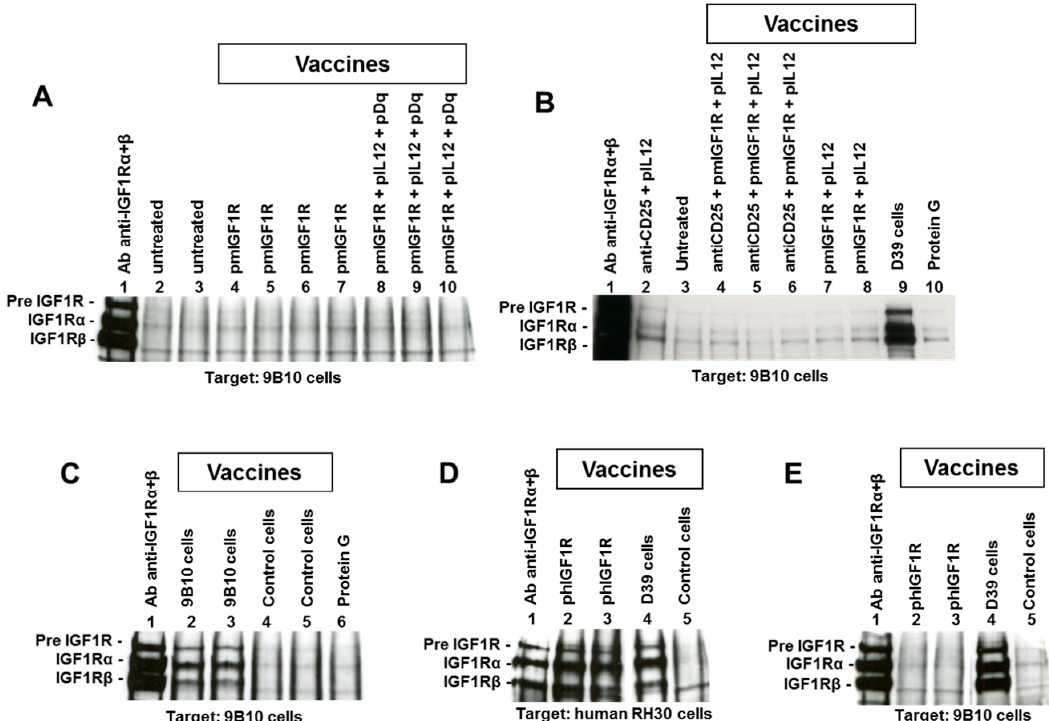
Figure 1. Immunoprecipitation and Western blot analysis of sera to evaluate the induction of antibodies recognizing murine or human Insulin-like Growth Factor Receptor-1 (IGF1R). In each panel sera used for immunoprecipitation are reported over each lane, while tumor cell lysate (target) is reported under each panel. For details, see the Materials and Methods section. ( A ) lane 1, positive control; lanes 2 to 3, sera from untreated BALB/c mice; lanes 4 to 7, sera from BALB/c mice after four vaccinations with pmIGF1Ropt plasmid; lanes 8 to 10, sera from BALB/c mice after four vaccinations with a combination of plasmids (pmIGF1Ropt, pIL12 and pDq). ( B ) lane 1, positive control; lane 2, serum from BALB-p53Neu pretreated with anti-CD25 and vaccinated with pIL12; lane 3, untreated; lanes 4 to 6, sera from BALB-p53Neu mice pretreated with anti-CD25 and vaccinated with pmIGF1Ropt and pIL12 plasmids; lanes 7 to 8, sera from BALB-p53Neu after three vaccinations with pmIGF1Ropt and pIL12 plasmids; lane 9, serum from BALB-p53Neu vaccinated with hIGF1R-expressing D39 cell vaccine (three vaccination cycles); lane 10, protein G alone (negative control). ( C ) lane 1, positive control; lanes 2 to 3, sera from BALB/c mice vaccinated with mIGF1R-expressing 9B10 cells (three cycles); lanes 4 to 5, sera from mice vaccinated with #20 control cells (three cycles); lane 6, protein G alone (negative control). ( D , E ) The same sera were used to immunoprecipitate either hIGF1R ( D ) or mIGF1R ( E ) as follows: Lane 1, positive control; lanes 2 to 3, sera from BALB/c mice after four vaccinations with p-hIGF1R plasmid; lane 4, serum from BALB/c mouse after three vaccination cycles with hIGF1R-expressing D39 cells; lane 5, serum from mouse vaccinated with #20 control cells (three cycles).